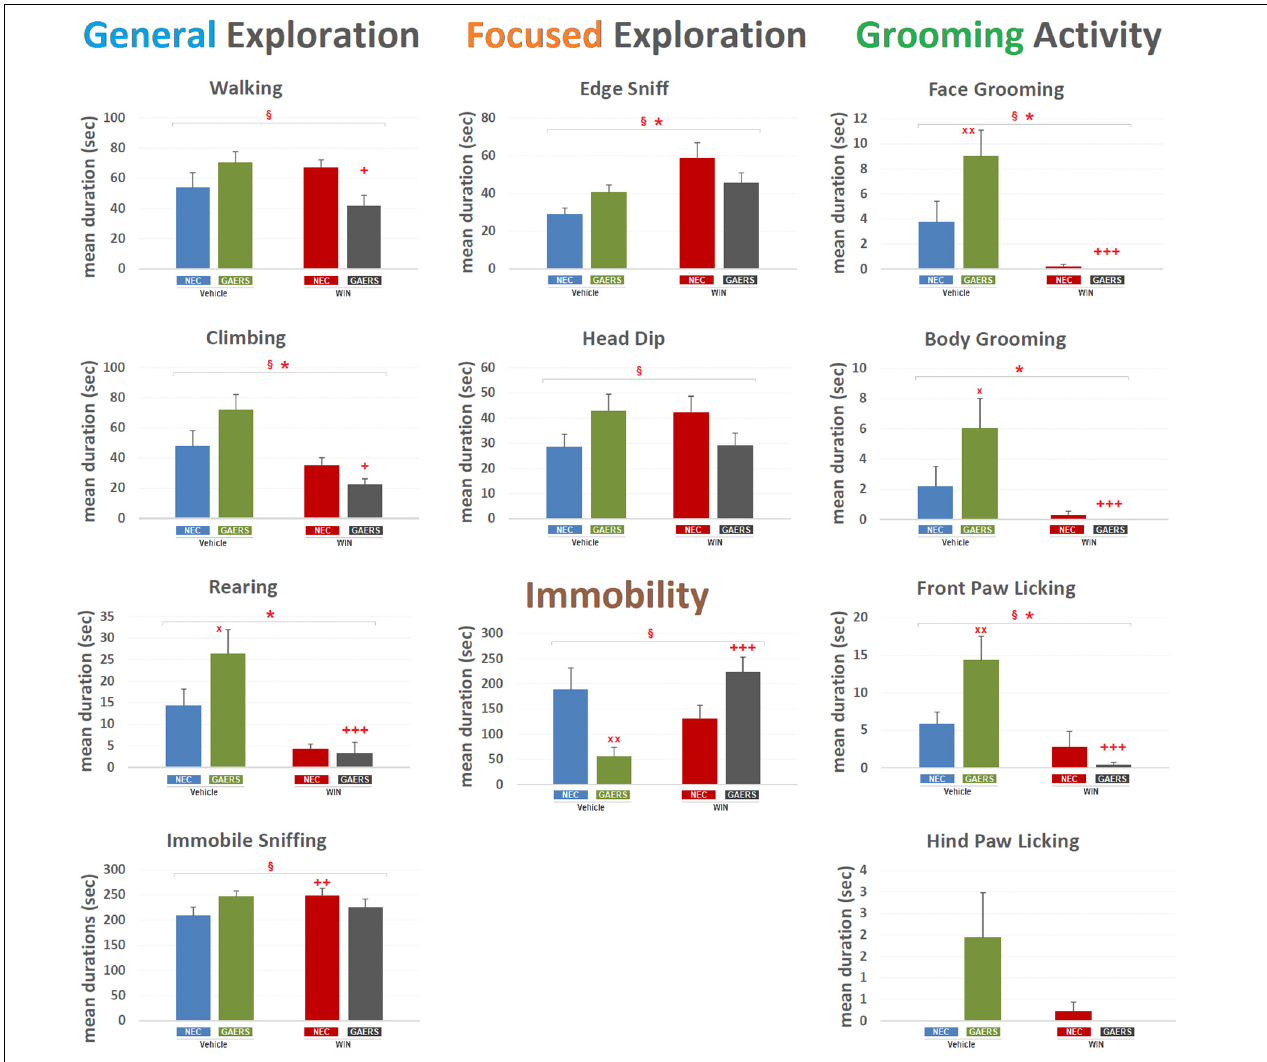
FIGURE 3 | Effect of WIN 55,212-2 and its vehicle on the duration of different behaviors of GAERS and NEC rats. Administration of WIN 55,212-2 (WIN; 2 mg/kg, IP) and its vehicle affected the mean duration ± SEM of several behaviors of GAERS and NEC rats detected during the 10 min of the hole-board test. Mean durations (sec) ± SEM of all the behavioral components of the behavioral repertoire. § = significant ( p < 0.05) interaction between factors (strain x treatment, two-way ANOVA); * = significant ( p < 0.05) main effect of pharmacological treatment (WIN vs. Vehicle, two-way ANOVA). x = significant difference between GAERS Vehicle vs. NEC Vehicle (Fisher’s LSD post hoc test for multiple comparisons). + = significant difference between GAERS WIN vs. GAERS Vehicle or between NEC WIN vs. NEC Vehicle (Fisher’s LSD post hoc test for multiple comparisons). x = p < 0.05, xx = p < 0.01; + = p < 0.05, ++ = p < 0.01, ++ + = p < 0.001. Data obtained from 15 rats in each